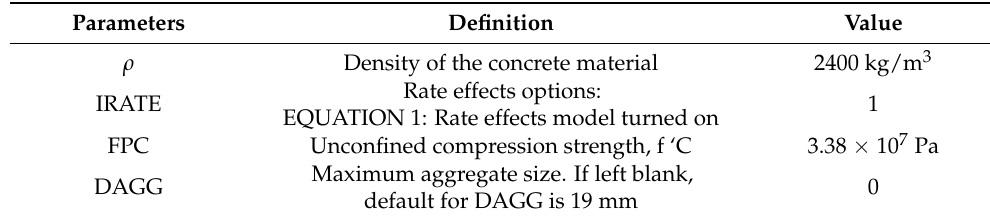
Table 4. Parameters of the concrete material model.